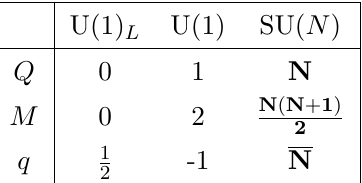
Table 1 . The quantum numbers of the chiral super(cid:12)elds for the left-moving R-symmetry U(1) L and a (cid:13)avor symmetry U( N